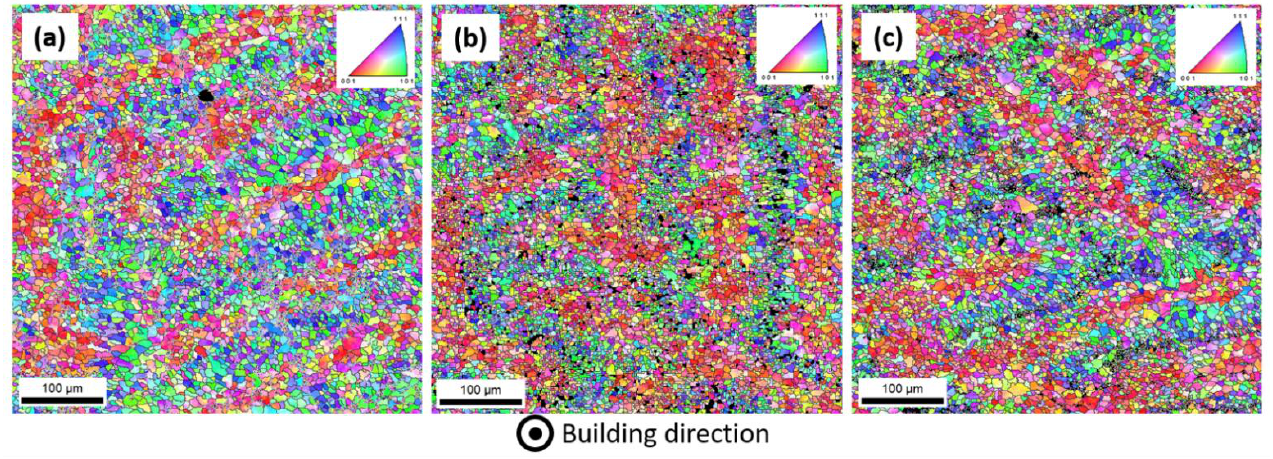
Figure 4. ( a , c , e ) SEM and ( b , d , f ) TEM micrographs of ( a , b ) as-built and annealed samples for ( c , d )